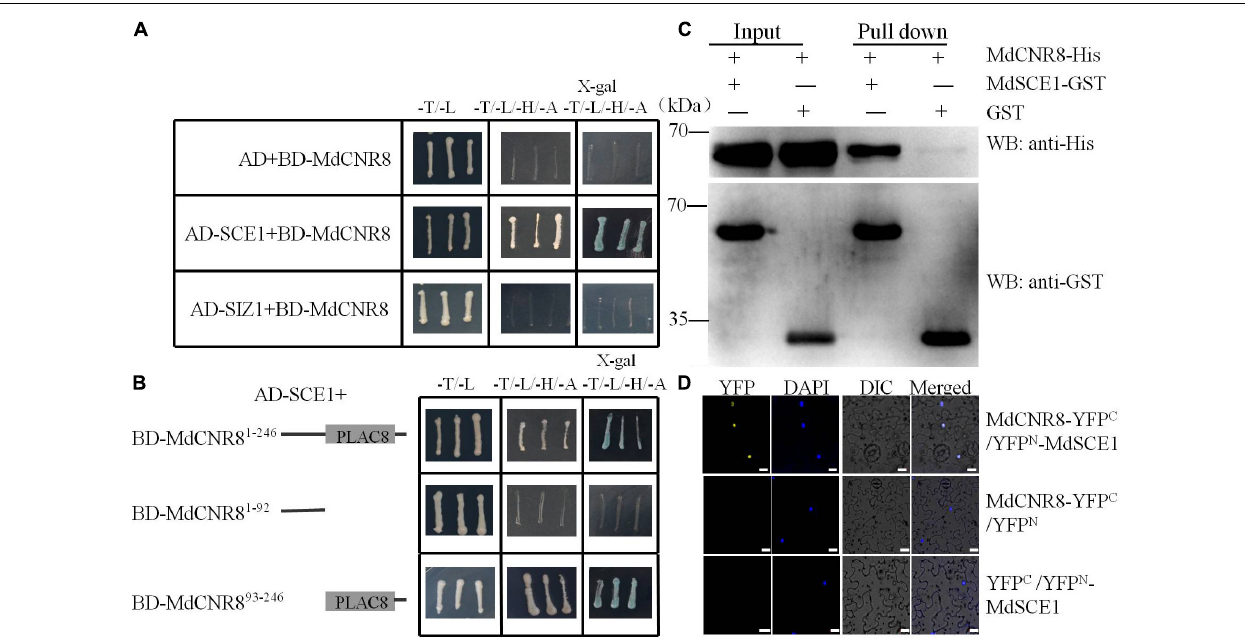
FIGURE 2 | MdCNR8 interacts with MdSCE1. (A) Interaction of MdCNR8 with MdSCE1 as shown by Y2H assays. The full-length MdCNR8 was cloned into vector pGBT9 (BD-MdCNR8). The MdSCE1 or MdSIZ1 was cloned into pGAD424 (AD-MdSCE1/AD-MdSIZ1). Empty vector AD + BD-MdCNR8 was used as a negative control. SD/-T/-L indicates synthetically defined medium lacking Leu and Trp; SD/-T/-L/-H/-A indicates synthetically defined medium lacking Leu, Trp, His, and Ade. x-gal, 5-Bromo-4-chloro-3-indolyl β -D-galactopyranoside. (B) Y2H segmentation assays for the interaction between the C-terminus containing PLAC8 conservative motif of MdCNR8 and MdSCE1. MdCNR8 1 − 92 and MdCNR8 93 − 246 vectors were fused to pGBT9 vector. (C) Pull-down assays for the interaction of MdSCE1 with MdCNR8. Escherichia coli- expressed GST or MdSCE1-GST proteins were incubated with a cobalt chelate affinity resin containing the immobilized histidine-tagged MdCNR8 protein. The proteins were detected via immunoblotting with anti-His and anti-GST antibody. (D) Biomolecular fluorescence complementation assays for the interaction between MdSCE1 and MdCNR8 proteins in nuclei of epidermal cells of tobacco. DAPI (4 (cid:48) ,6-diamidino-2-phenylindole) was used to stain the nuclei. YFP, yellow fluorescent protein; differential interference contrast (DIC), bright field. Bars = 20 µ m.